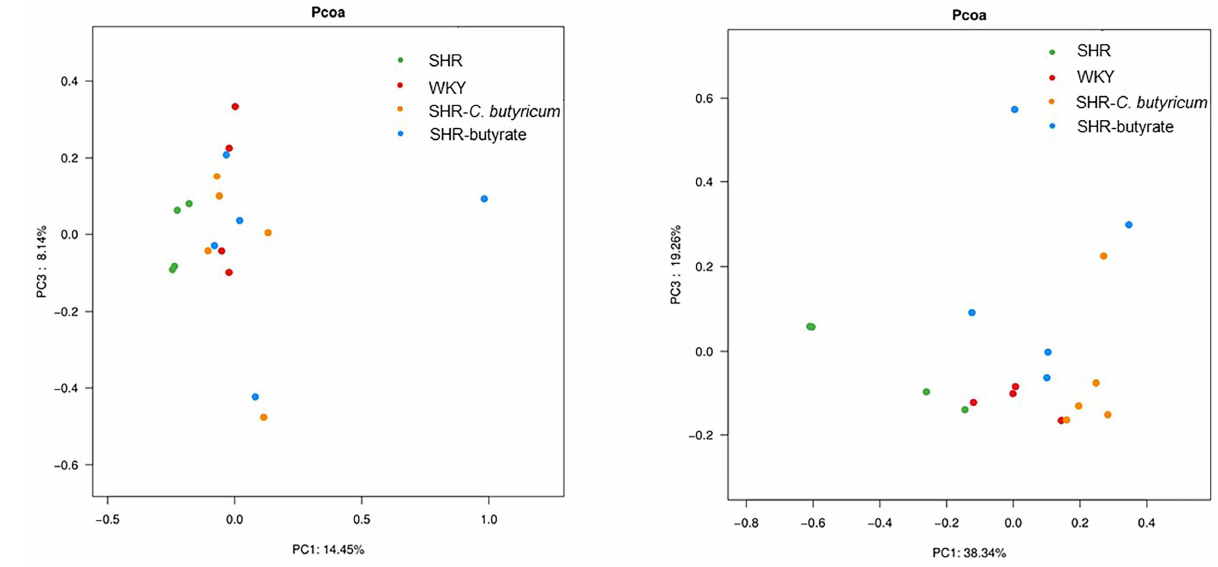
Figure 3. Beta diversity of gut microbes analyzed by PCoA. PCoA used unweighted UniFrac analysis and weighted UniFrac analysis to calculate the distances between the six groups in the colonic stool samples (SHR and WKY, n = 6 per group, SHR- C. butyricum and SHR-butyrate, n = 8 per group).